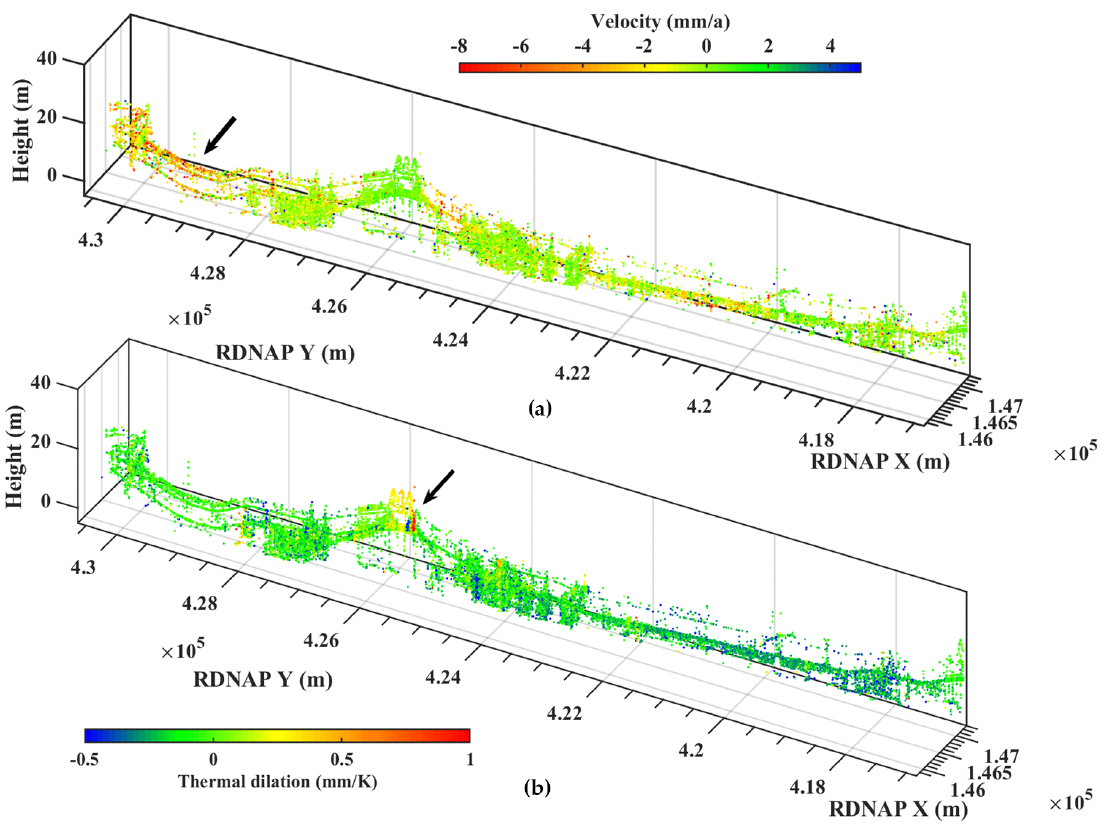
Figure 8. Parameters of the scatterers with corrected coordinates: ( a ) deformation velocity, demonstrating the instability of the north area; and ( b ) thermal dilation, showing the strong thermal dilation of the bridge structure.